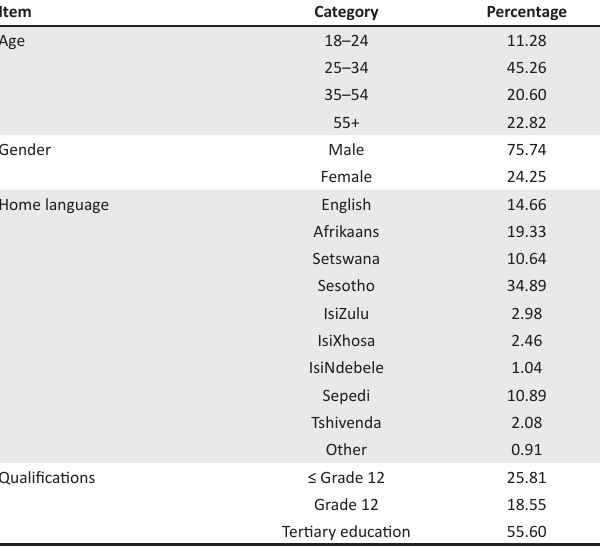
TABLE 1: Demographical